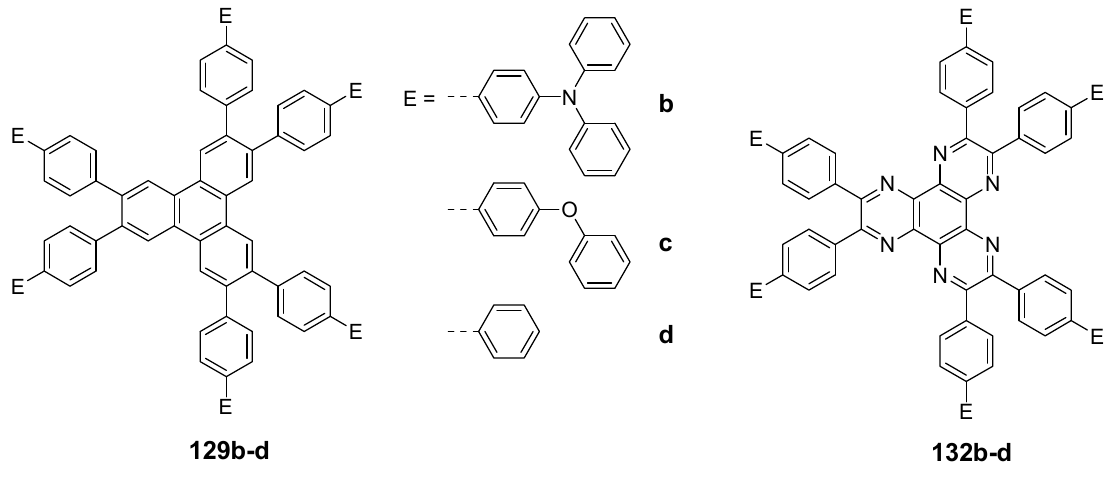
Figure 31. Extented triphenylene stars showing efficient energy transfer in